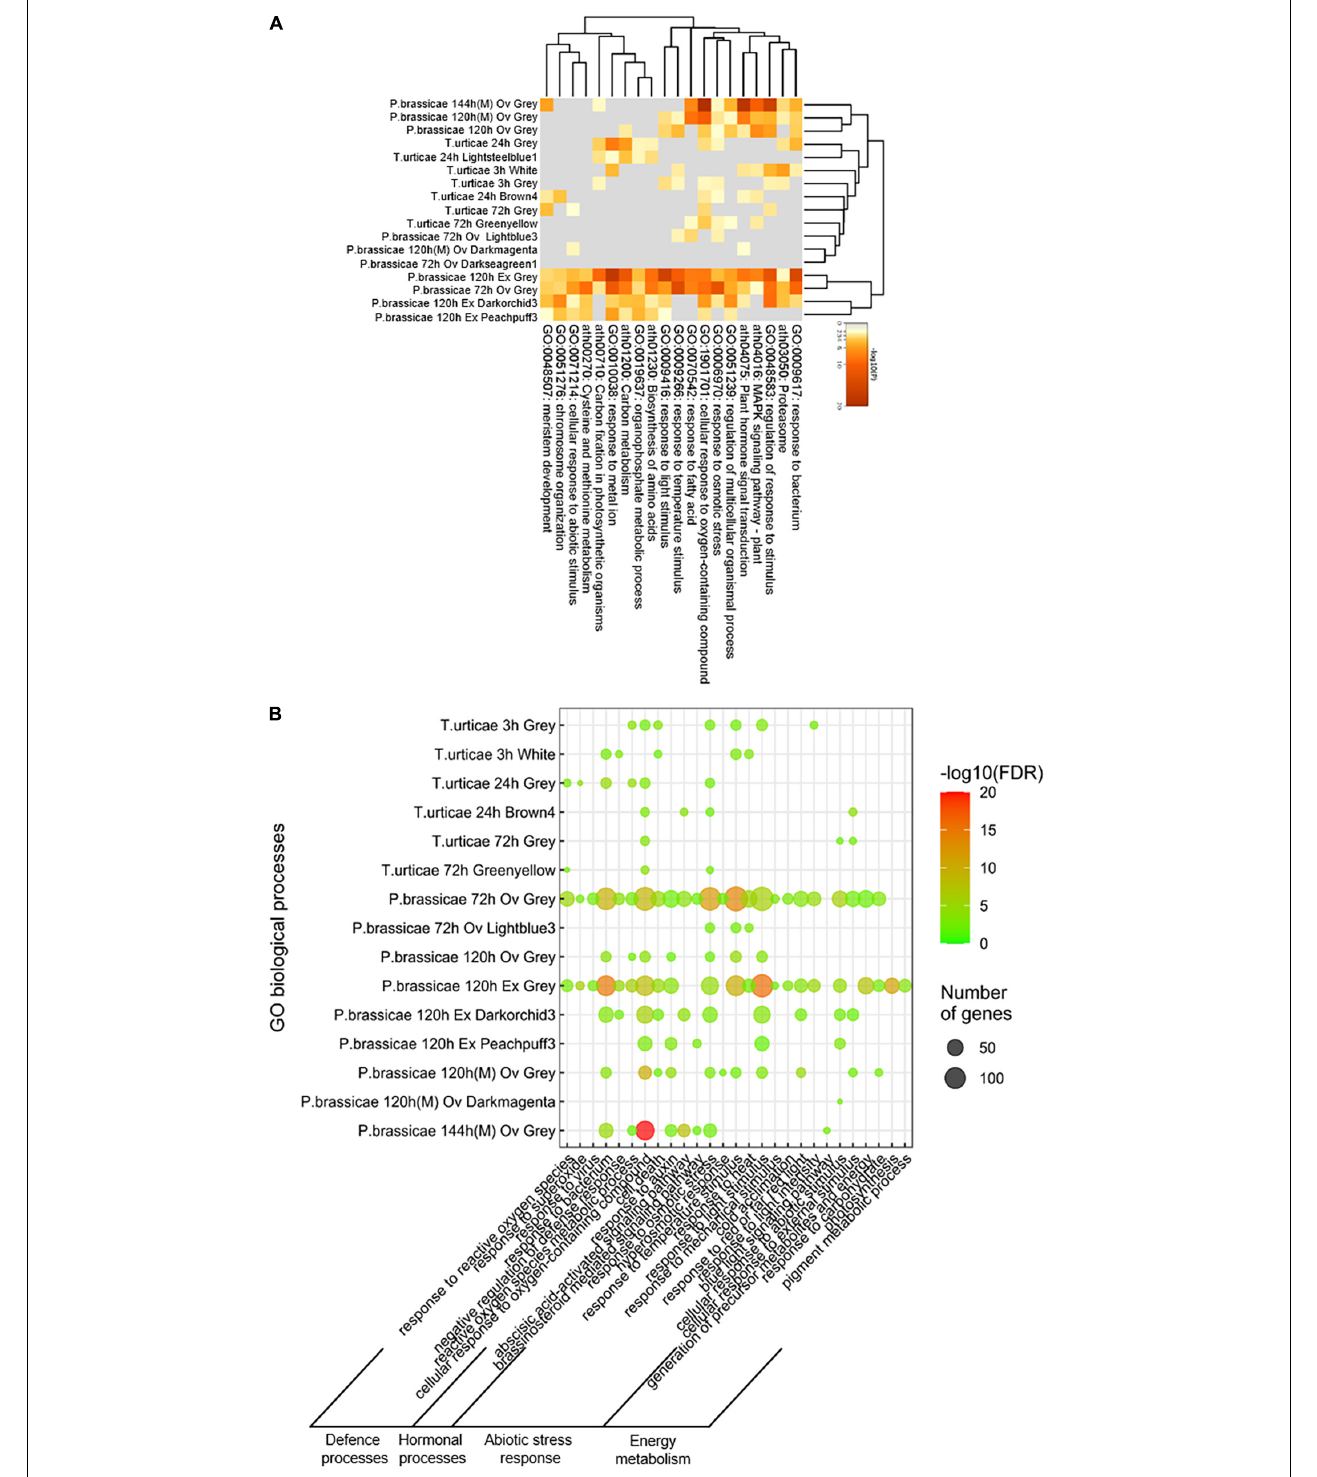
FIGURE 4 | Gene enrichment analysis of the BP ontologies for each module of co-expressed genes. (A) Heatmap of the enriched ontologies across modules, colored by p -values. (B) Representation of the four groups that formed the top enriched terms across the experiments. Species and time (h) are stated for each study; stresses are identified as Ov (oviposition) and Ex (egg extract). All T. urticae data were obtained from egg extract stress. Microarray results are classified by an (M) at the end of the identification, the rest of the results were obtained from RNA-seq data. Enrichment was calculated based on Benjamini–Hochberg tests (FDR ≤